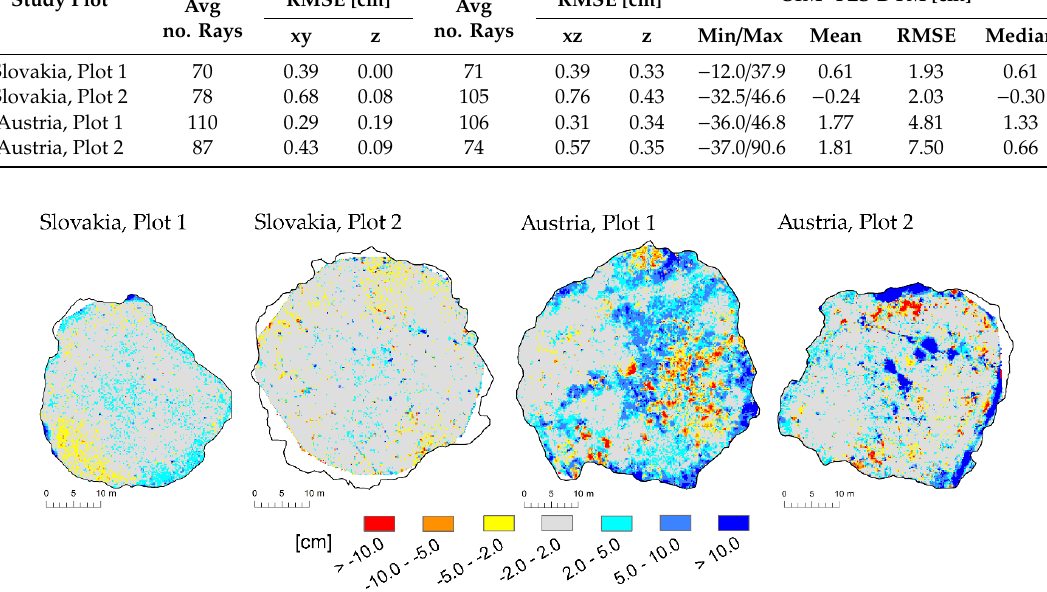
Table 3. RMSEs of GCPs and CPs for each plot, and height differences between SfM and TLS DTMs. Study Plot